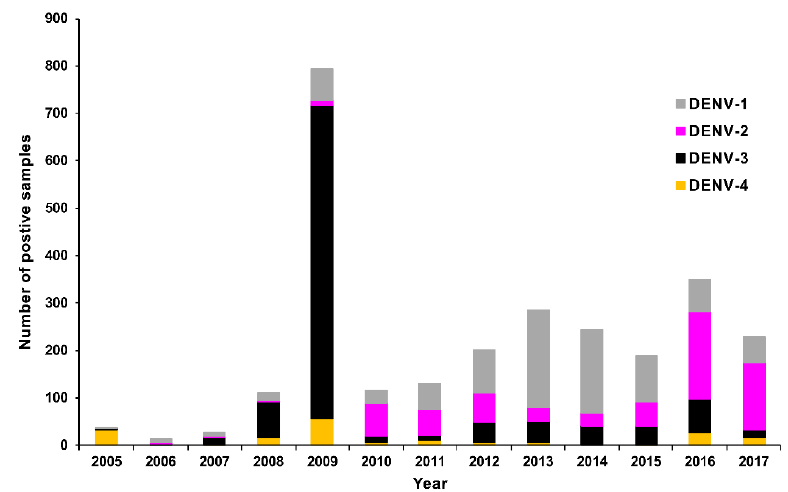
Figure 3. Summary of confirmed DENV 1 – 4 RT-rtPCR/RT-PCR-positive samples reported by PHV, Queensland between 2005 and 2017 by year and serotype.